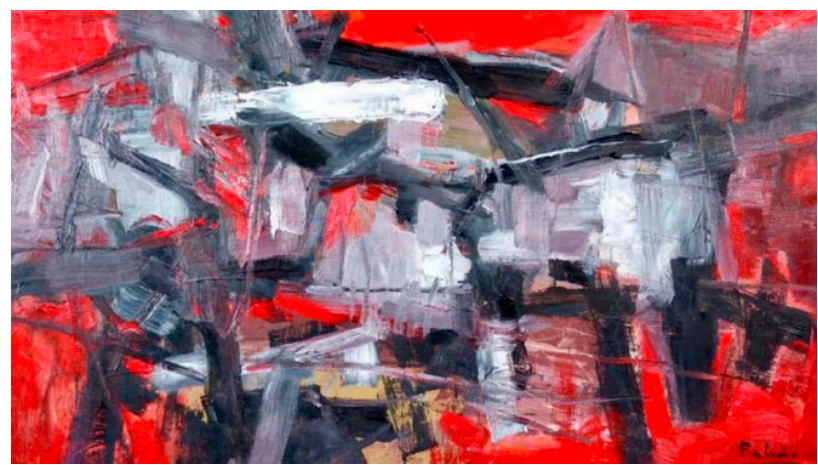
Figure 4. Fake Pham An Hai’s Du am pho co . The image was sourced from Tuoi Tre Newspaper Thi Minh (Viet 2017).